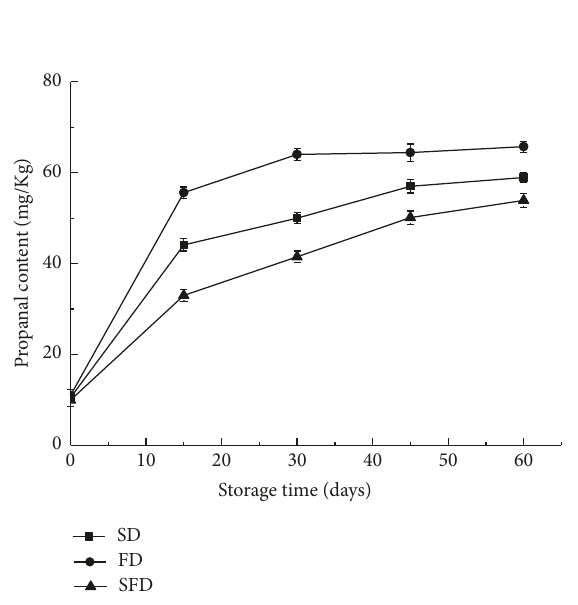
Figure3:Releaseprofileoffishoilmicrocapsulesbydifferentdrying methods.